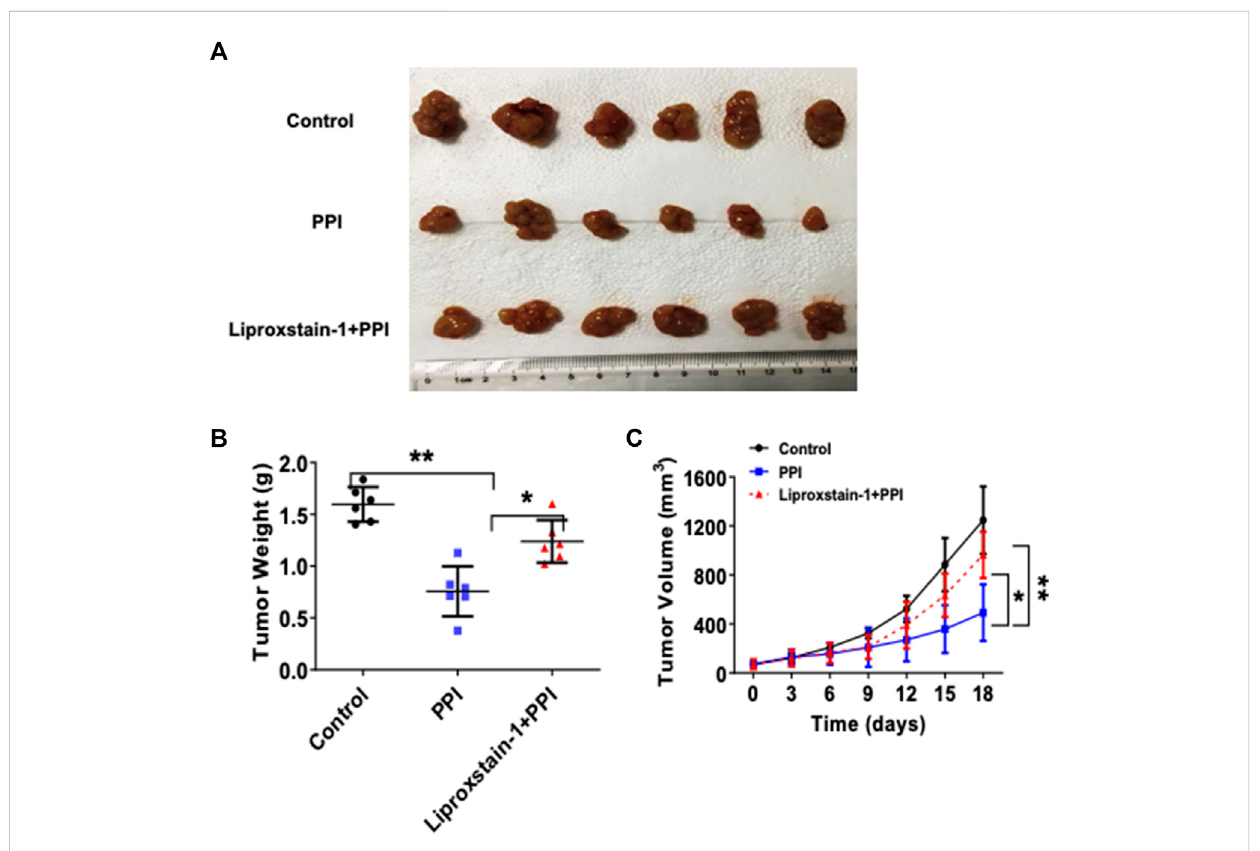
FIGURE 5 Liproxstain-1 reverses the inhibitory effects of PPI on tumor growth in vivo . BALB/c nude mice were subcutaneously injected with 1×10 6 AGS cells. One week later, the mice were administered with PPI (3 mg/kg/day) alone or in combination with liproxstain-1. (A) The tumor xenografts were harvested at day 15, and photographs of tumor xenografts were taken ( n = 6 mice/group). (B) The weights of tumors derived from the nude mice were also measured at day 15. (C) Finally, tumor volumes were determined at various time points for up to 18 days. Data are presented as mean ± SD ( n = 6 mice/group, * p < 0.05; and ** p <